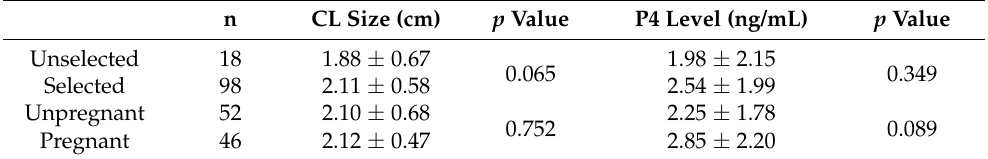
Table 2. CL sizes and P4 levels of cows either unselected or selected by embryo transfer operator ( n = 116). n